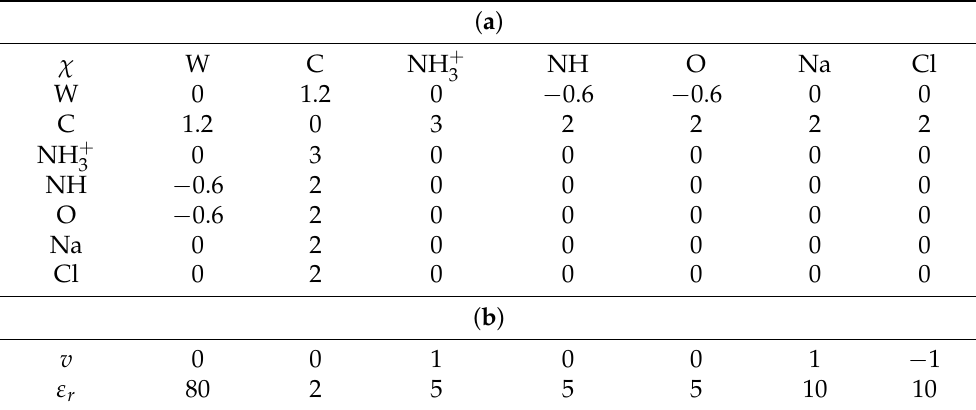
, neutral NH and O, 3